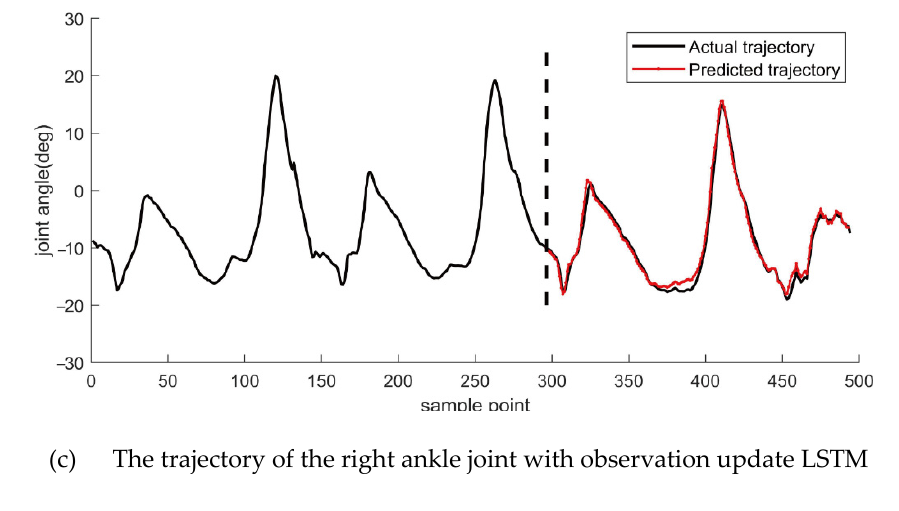
The trajectory of the right ankle joint with observation update LSTM